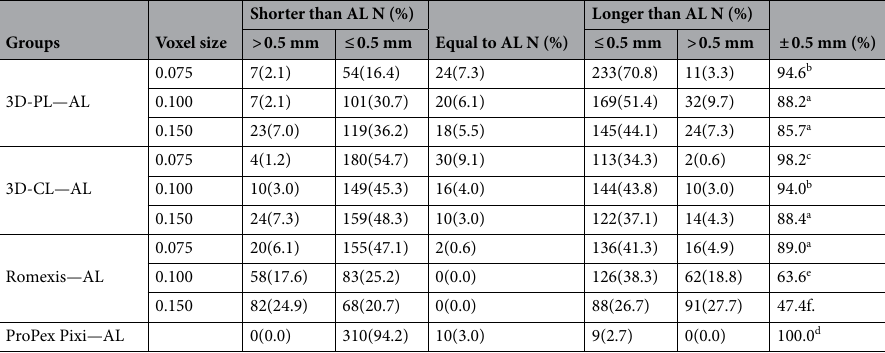
Table 1. The incidence (%) of differences between the actual length and length measurements using CBCTs and the EAL. AL, Actual Length; PL, Proposed Length; CL, Corrected Length. a,b,c,d,e,f Superscript different letters indicated the significant differences at P < 0.0. (Fisher’s Exact test).